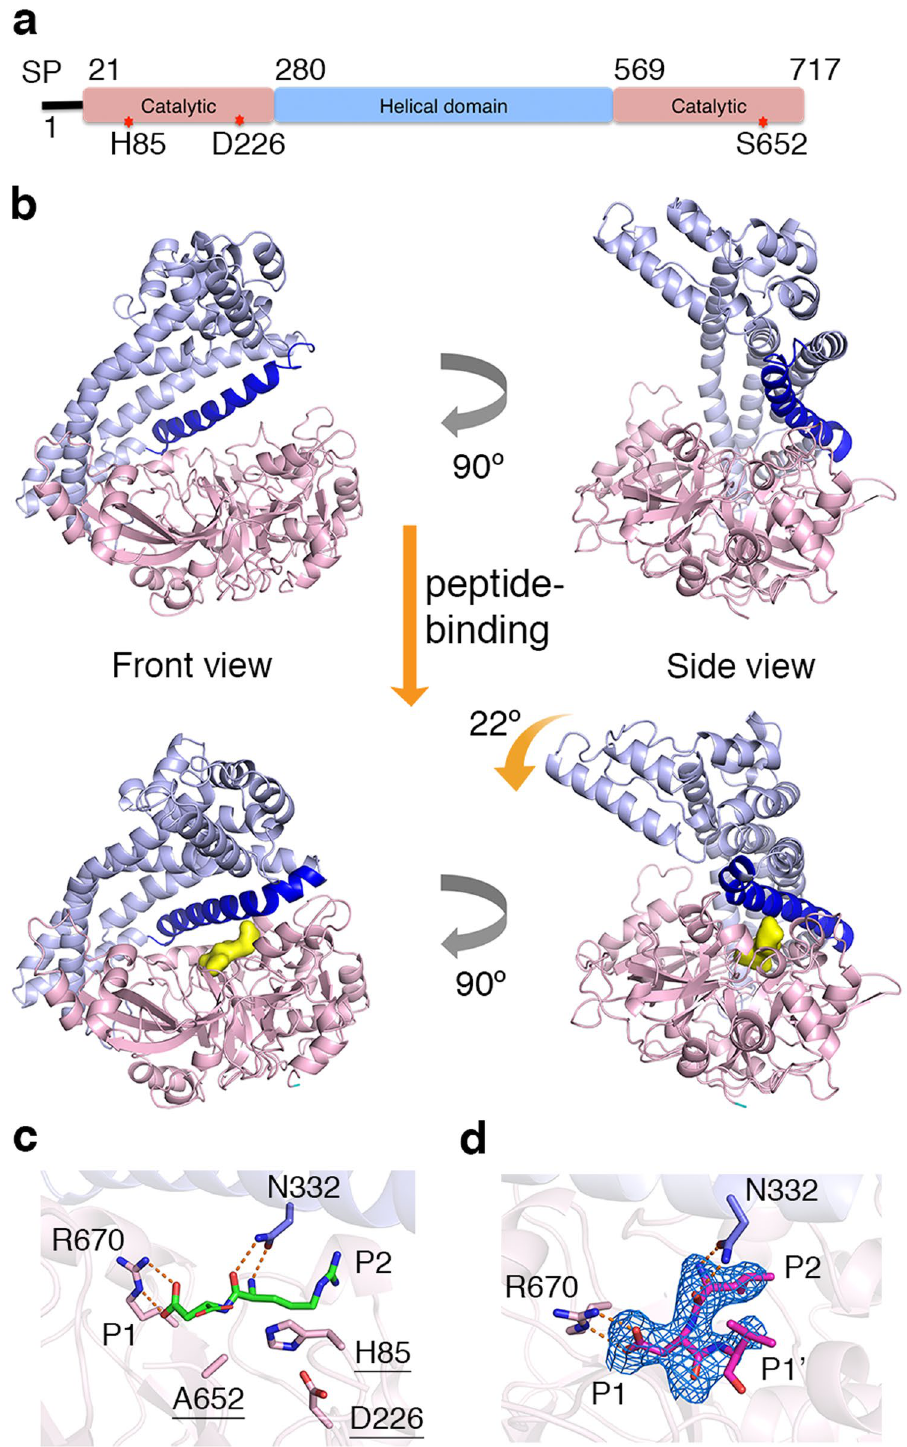
Figure 1. Structure of Porphyromonas endodontalis DPP11. (a) Domain architecture of PeDPP11. SP is signal peptide. The locations of catalytic triad amino acids are indicated by “red stars”. (b) Ribbon representation of PeDPP11 structure. Domains are coloured as in item (a) and helix α 14 is shown in dark blue. Upper panel shows two perpendicular views of unbound PeDPP11. Lower panel shows two perpendicular views of PeDPP11 as in complex with peptides (binding pocket shown as yellow surface). (c) Active site of PeDPP11:RD (peptide RD shown in green). Catalytic triad is underlined. Note that S652 is mutated to alanine. (d) Active site of PeDPP11:LDVW (peptide LDVW shown in magenta), peptide omit map contoured at 3 σ , shown in